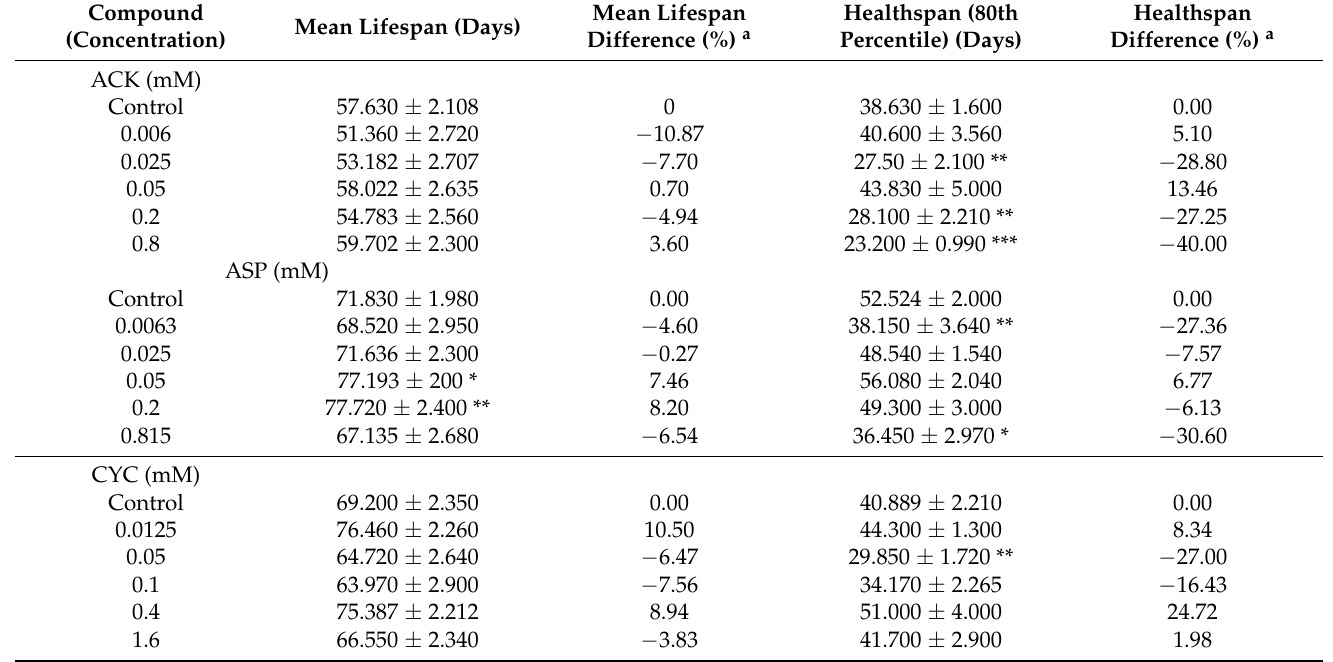
Table 4. Effects of ACK, ASP and CYC treatments on the Drosophila melanogaster mean lifespan and